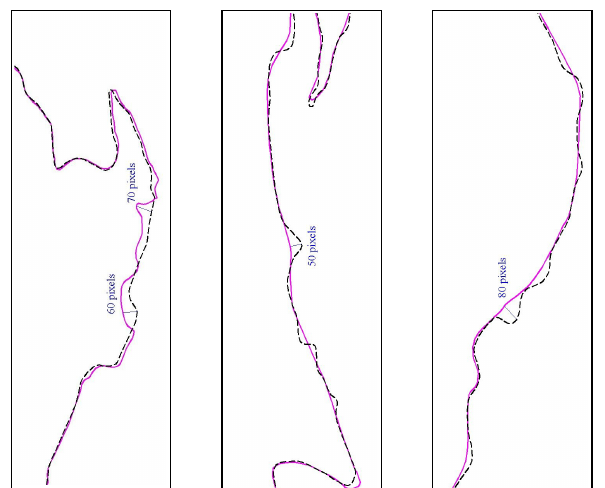
Figure 7. Test B: Road sections with wide temporal changes.